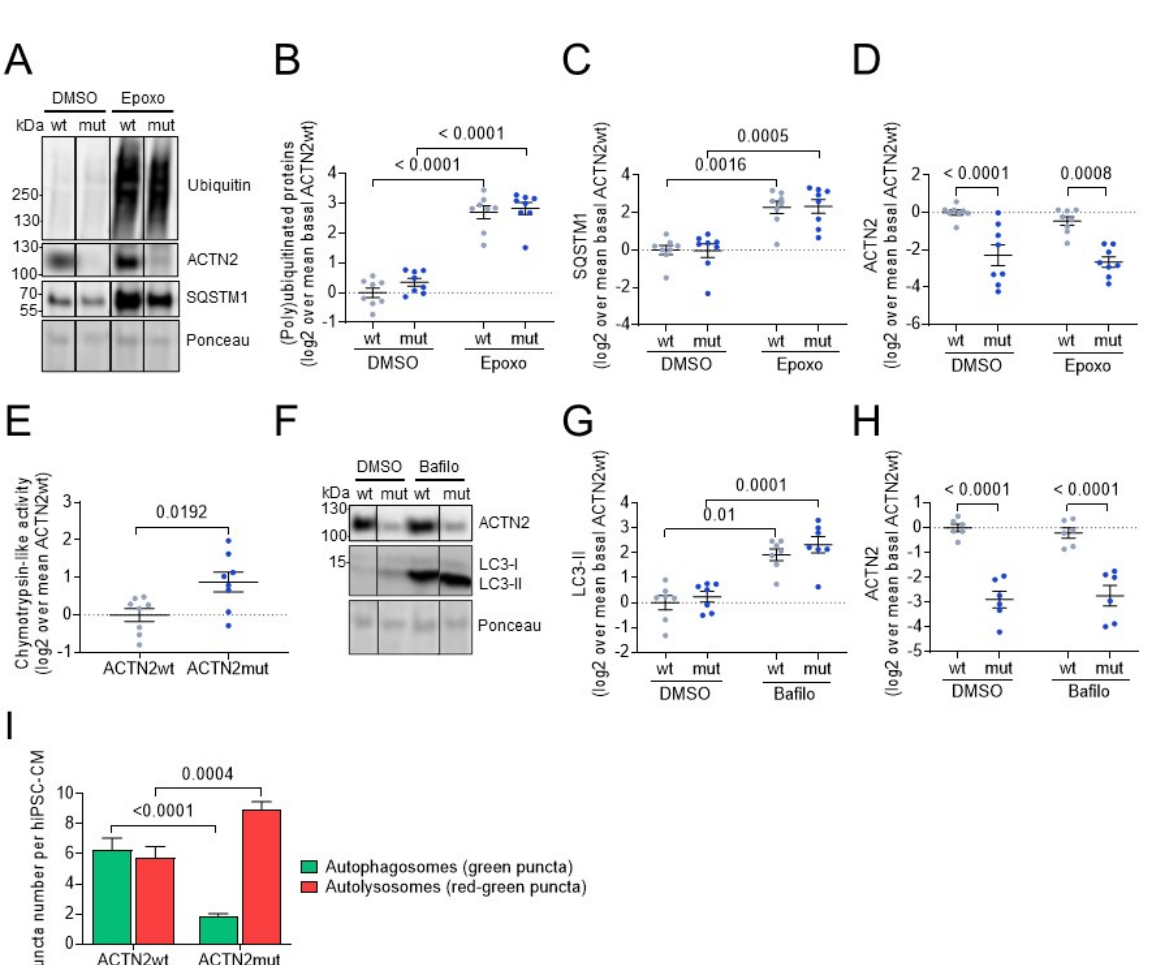
Figure 4. Evaluation of the impact of the ACTN2 gene variant on the proteolytic systems in 30 ‐ day ‐ old, 2D ‐ cultured hiPSC ‐ CMs. Representative Western blots and Ponceau ( A ), and quantification, normalized to Ponceau, of the levels of ( B ) (poly)ubiquitinated proteins, ( C ) SQSTM1, ( D ) ACTN2 in hiPSC ‐ CMs treated with DMSO (0.05%) or epoxomicin (Epoxo; 250 nM) for 16.5 h at 37 °C (ACTN2wt: n/d = 7–8/3, ACTN2mut: n/d = 7–8/3). ( E ) Chymotrypsin ‐ like activity of the proteasome in hiPSC ‐ CMs (ACTN2wt: n/d = 8/3, ACTN2mut: n/d = 8/3). ( F ) Representative Western blots, Ponceau, and quantification of protein levels of ( G ) LC3 ‐ II and ( H ) ACTN2 of hiPSC ‐ CMs treated with DMSO (0.05%) or bafilomycin A1 (Bafilo; 50 nM) for 3 h at 37 °C (ACTN2wt: n/d = 6–7/3, ACTN2mut: n/d = 6–7/3). ( I ) The ALP activity was indirectly measured by determining the number of autophagosomes (green puncta) and autolysosomes (red minus green puncta) whereby the number of puncta is related to the CM number per well (ACTN2wt and ACTN2mut: n = 9). Data are expressed as mean ± SEM, with p ‐ values obtained with two ‐ way ANOVA and Tukey’s post ‐ test (panels B – D , G – I ) or with unpaired Student’s t ‐ test (panels E ). Abbreviations: n/d, number of wells/differentiations.